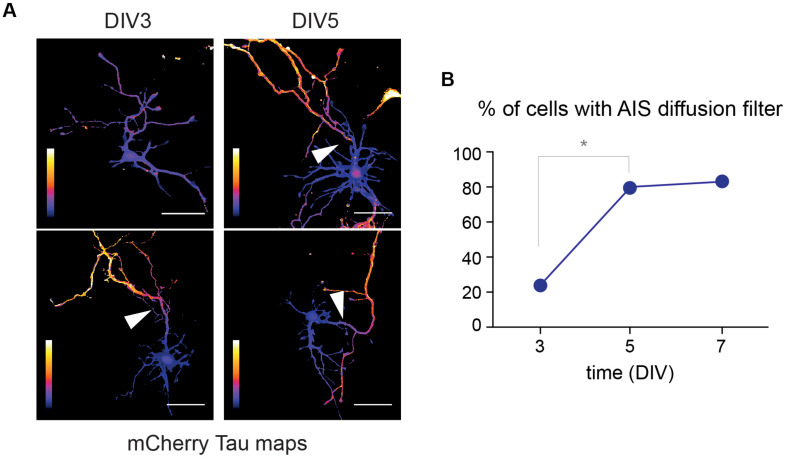
The filtering of cytoplasmic protein in the axon is developmentally regulated. (A) Tau heat maps of mCherry decay in DIV3 and DIV5 neurons illustrating the occurrence or lack of occurrence of a cytoplasmic diffusion barrier (arrowheads). Scale bar 50 μm. (B) Proportion of neurons exhibiting such a diffusion barrier at DIV3, 5, and 7, documenting the progressive maturation of the AIS (*p < 0.01; Fisher’s exact test, N = 13, 15, and 6 neurons, at DIV3, 5, and 7, respectively).